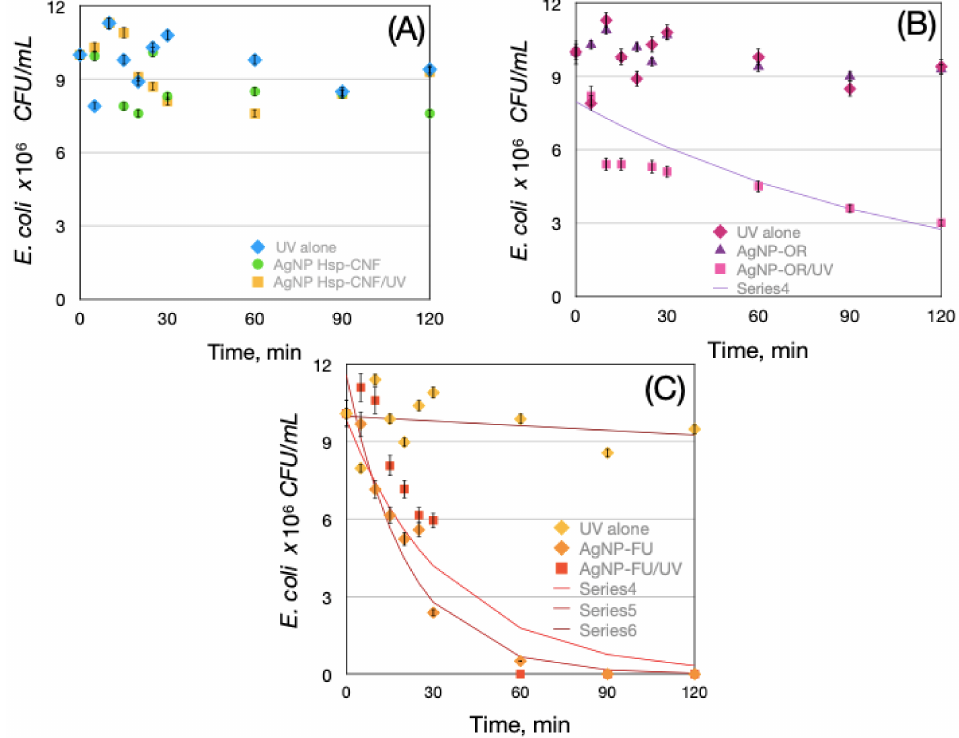
Figure 2. E. coli inactivation with UV radiation expressed as remaining CFU/mL over time using silver nanoparticles obtained using bio-based synthesis. ( A ) AgNP Hsp-CNF, hesperidin (isolated from orange peels) and stabilized with cellulose nanofibers; ( B ) AgNP-OR, orange peels water extract; and ( C ) AgNP-FU, fungal filtrate water extract. Graphs show UV alone (364 nm), and in joint action with